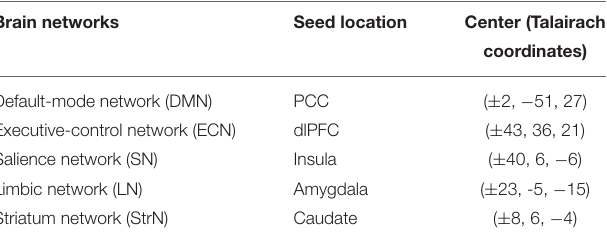
TABLE 2 | Seeds locations used to define brain